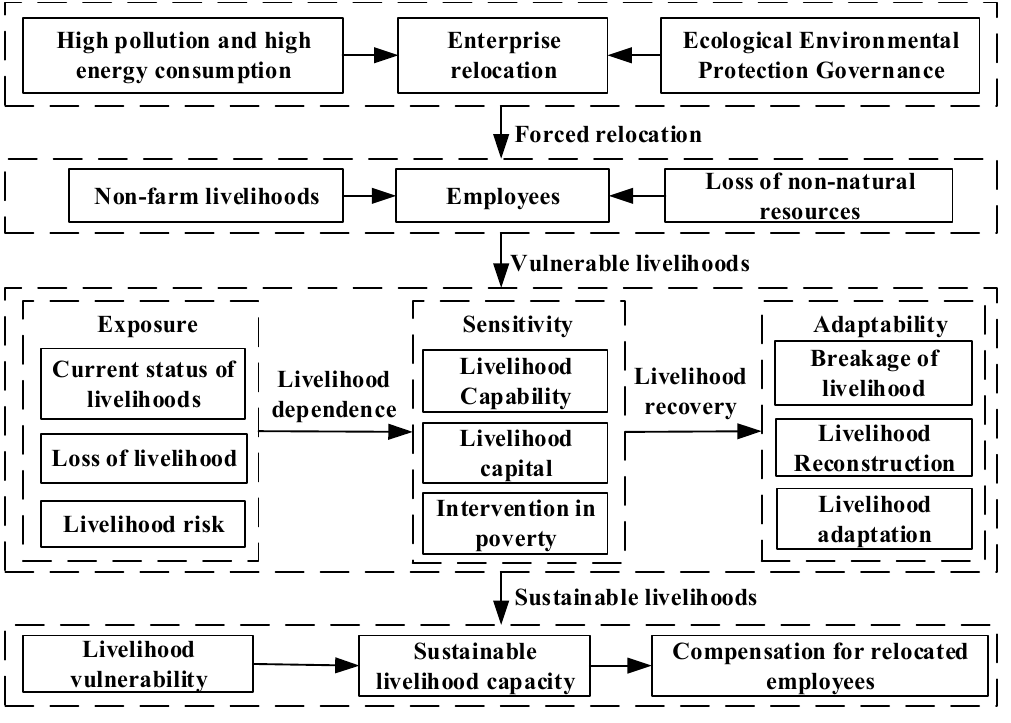
Figure 1. Research framework.